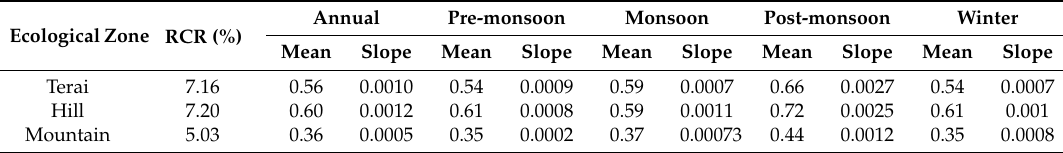
Table 2. Annual and seasonal mean NDVI and trends (year − 1 ) in three different ecological zones in Nepal, 1982–2015.